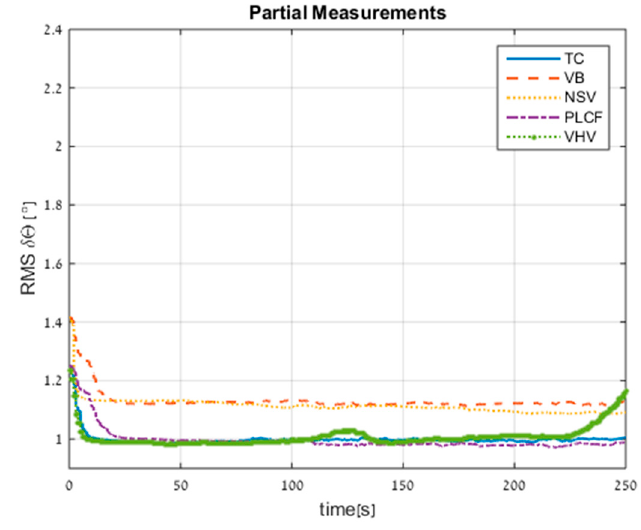
Figure 12. RMS errors of attitude for all approaches obtained from trajectory #2.